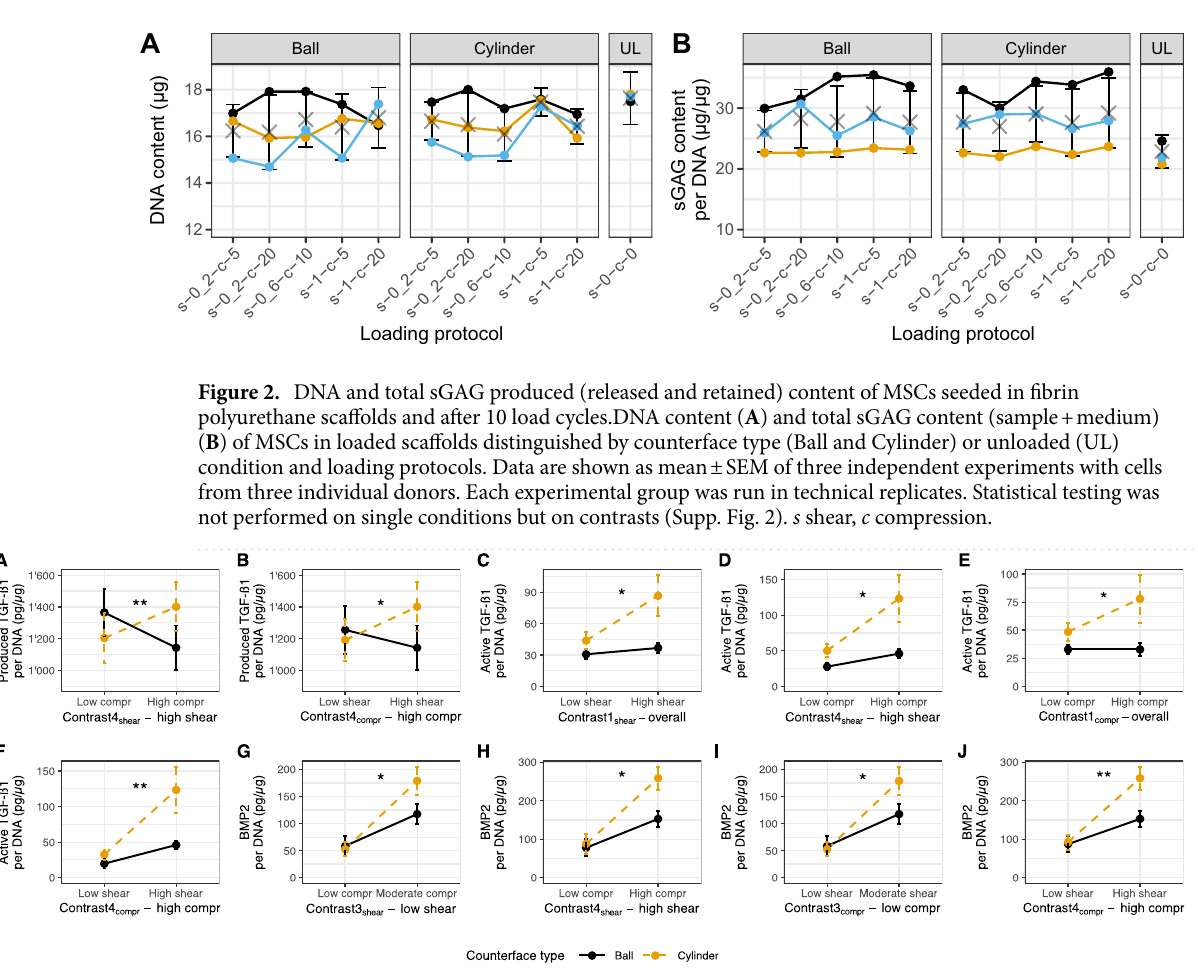
Figure 3. Interaction plots of significant contrasts split first by shear ( A , C , D , G , H ) and by compression ( B , E , F , I , J ) for produced and active TGF-β1 and BMP2 content. Data are shown as mean ± SEM of three independent experiments with cells from three individual donors. Each experimental group was run in technical replicates. Different loading conditions summarized in contrast groups according to Tables 3 and 4. Significance of interaction between counterface type and contrast groups tested using a linear mixed model with donor as random effect: * p <